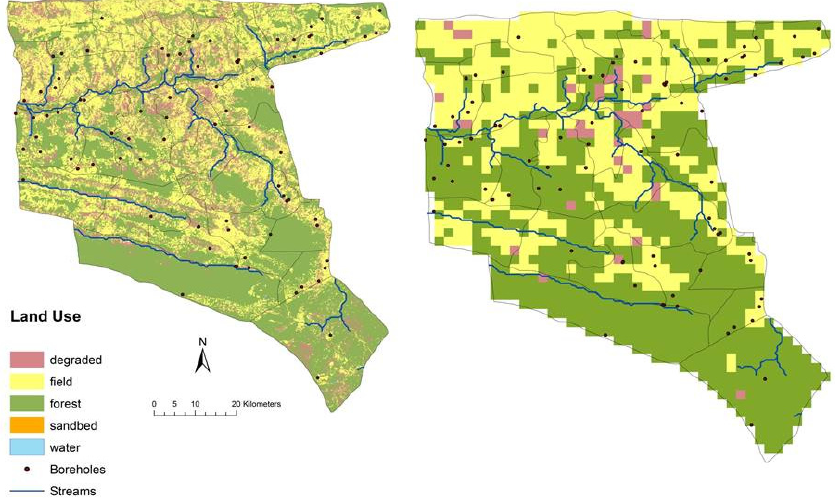
Figure 4. Nkayi District land use map converted to 2 km resolution grid used as inputs to the SAVANNA model.